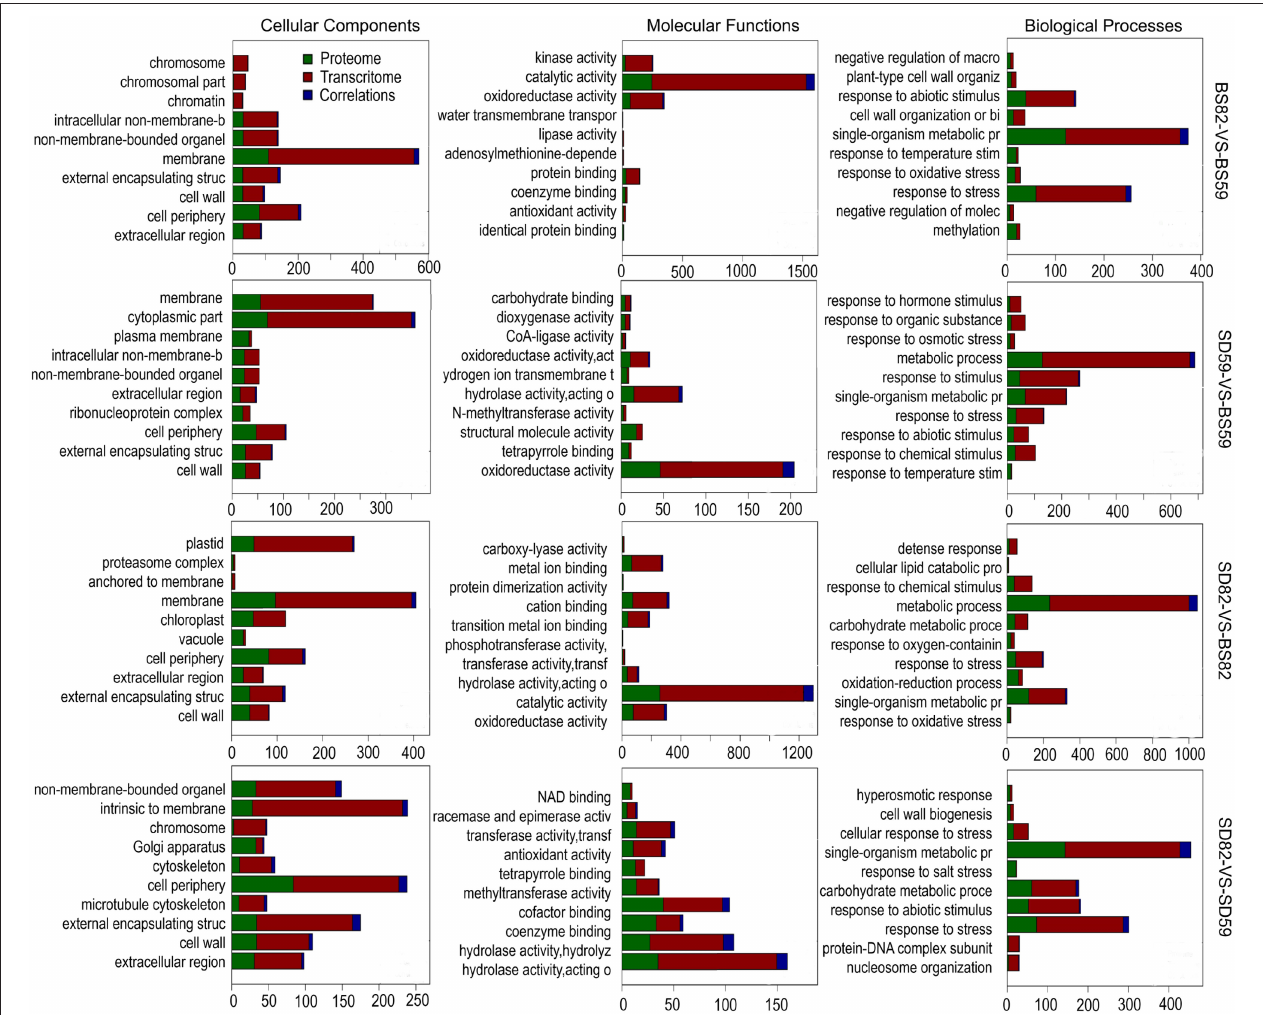
FIGURE 5 | Gene Ontology enrichment analysis of the DEGs (differentially expressed genes) and DEPs (differentially expressed proteins) in the BS82-VS-BS59, SD59-VS-BS59, SD82-VS-BS82, and SD82-VS-SD59 groups at the transcriptome and proteome levels, respectively.